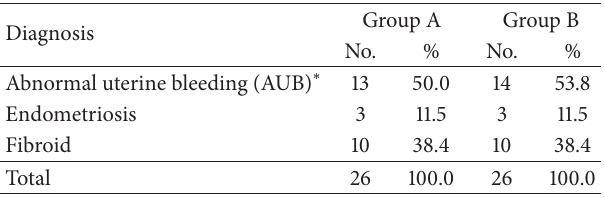
∗ AUB are those cases where medical management failed.